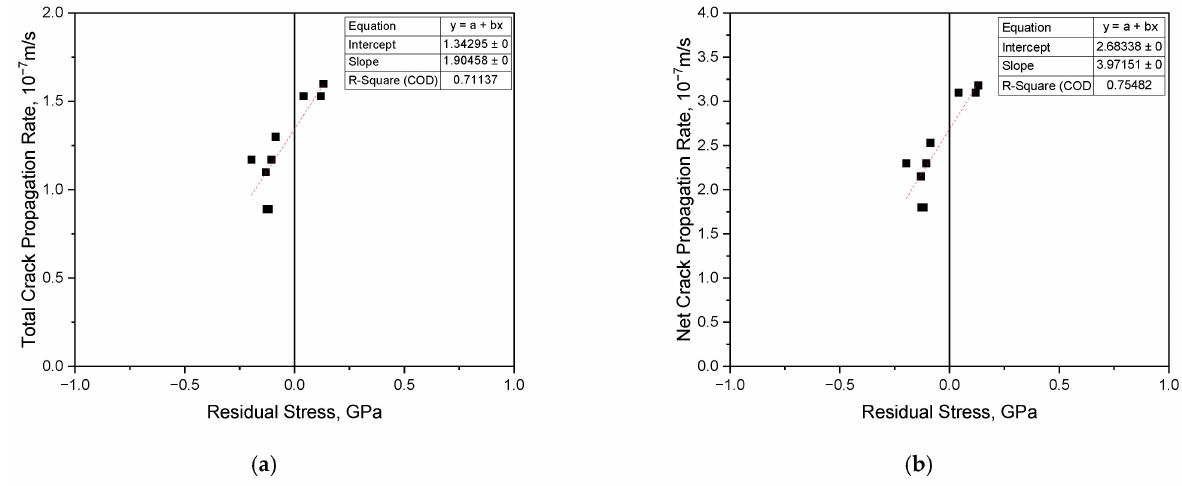
Figure 15. Relationship between the crack propagation rate and residual stress: ( a ) total crack propagation, ( b ) net crack propagation rate.